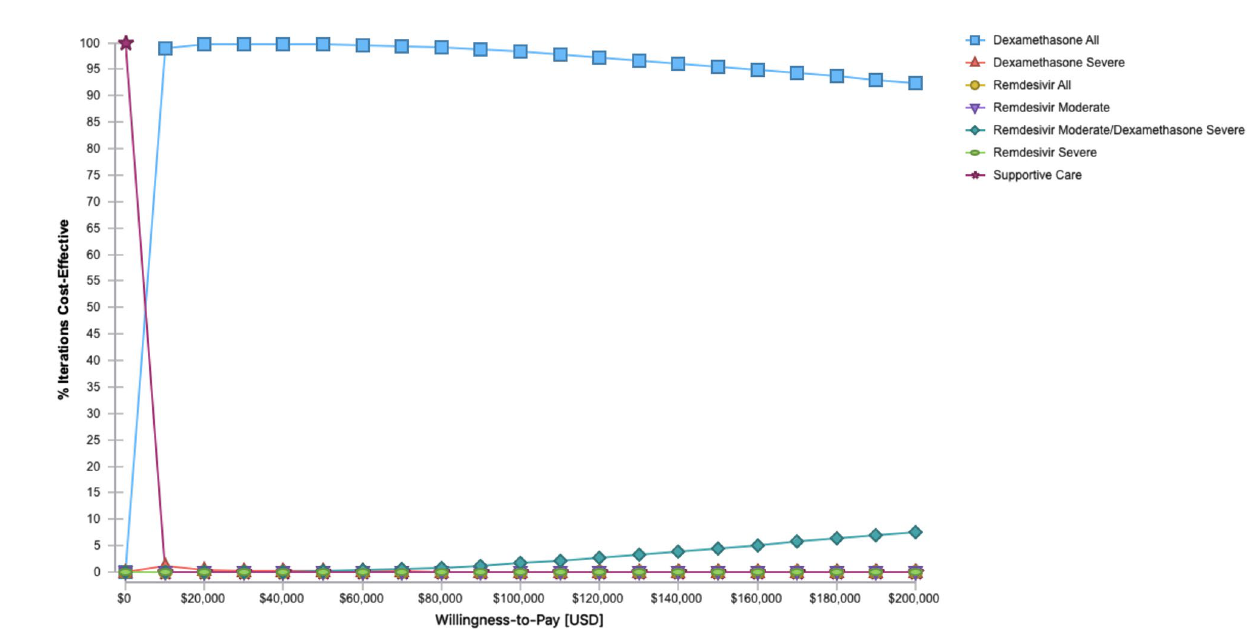
Figure 2. Cost effectiveness acceptability curve with probabilistic sensitivity analysis. Analysis of likelihood of a strategy being preferred based on the willingness to pay threshold in 2020 US dollars. Dexamethasone for severe infections, remdesivir for moderate infection and remdesivir for all overlap at